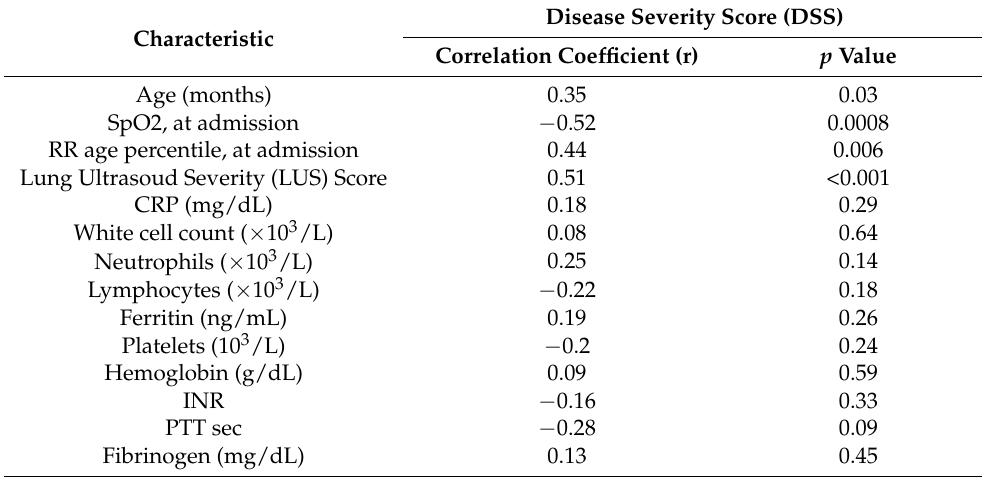
Table 4. The correlation between DSS and the clinical and laboratory parameters in children hospital- ized for COVID-19